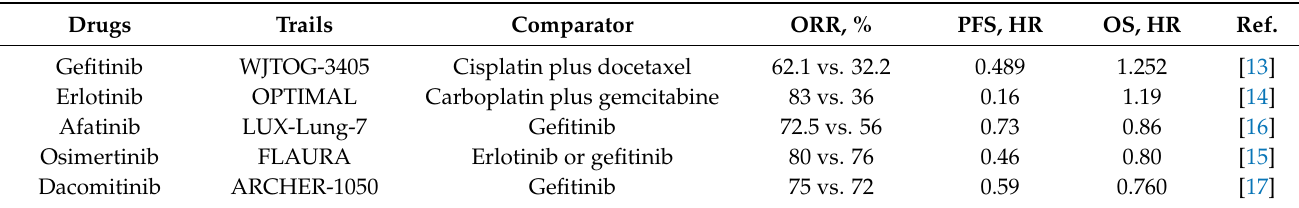
Table 1. Part of the key randomized trials in EGFR -positive